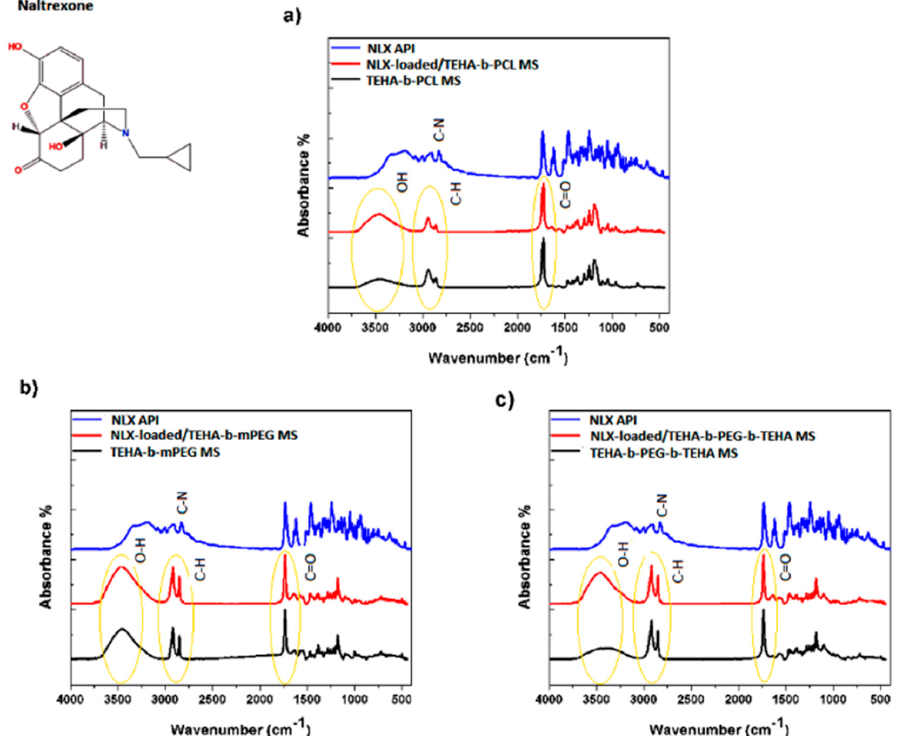
Figure 5. FTIR spectra of NLX in comparison with drug-free and drug loaded microspheres prepared from amphiphilic TEHA-based polymers: ( a ) TEHA-b-PCL; ( b ) TEHA-b-mPEG and ( c ) TEHA-b-PEG-b-TEHA.